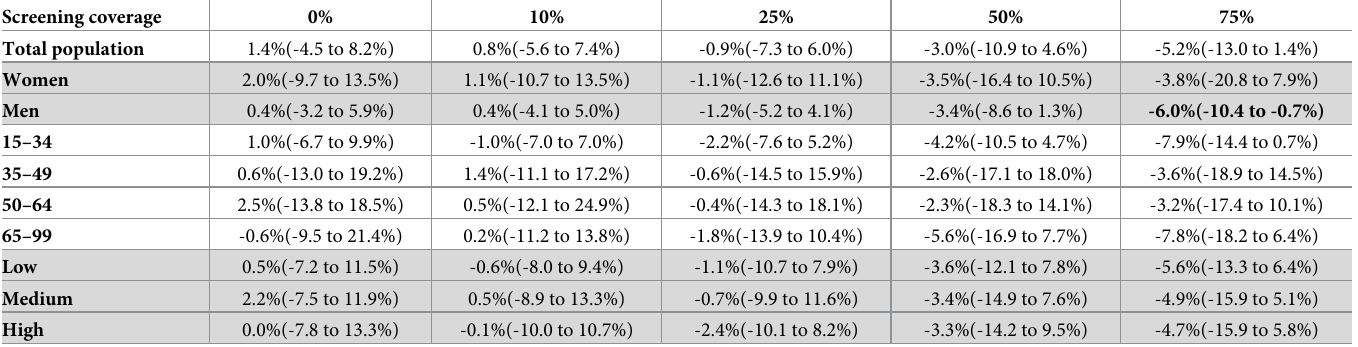
Table 3. Differences in prevalence of heavy episodic drinking in different alcohol screening rate scenarios, as compared to baseline scenario at the end of the ten- year simulation period. Screening